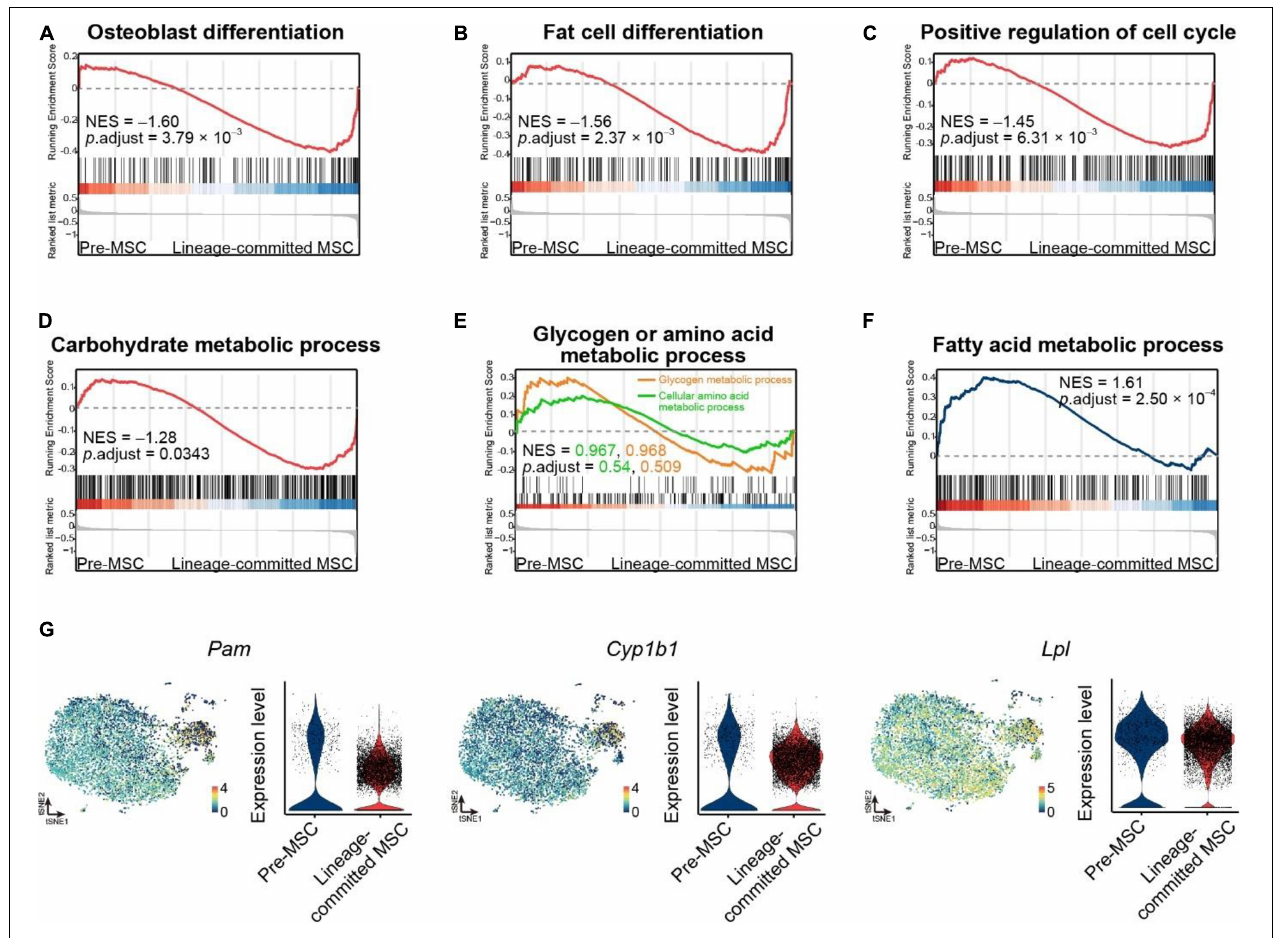
FIGURE 3 | The FA metabolic process regulates MSC lineage commitment. (A,B) GSEA evaluating enrichment of osteoblast (A) or fat cell differentiation genes (B) in pre- and lineage-committed MSCs. Normalized enrichment score and adjusted p -value were calculated by permutation tests. (C) GSEA evaluating enrichment of cell cycle genes in pre- and lineage-committed MSCs. Normalized enrichment score and adjusted p -value were calculated by permutation tests. (D,E) GSEA evaluating enrichment of carbohydrate (D) , glycogen, and amino acid metabolic process genes (E) in pre- and lineage-committed MSCs. Normalized enrichment score and adjusted p value were calculated by permutation tests. (F) GSEA evaluating enrichment of FA metabolic process genes in pre- and lineage-committed MSCs. Normalized enrichment score and adjusted p -value were calculated by permutation tests. (G) Feature plots and violin plots showing the selected fatty acid metabolic process genes expression in 8883